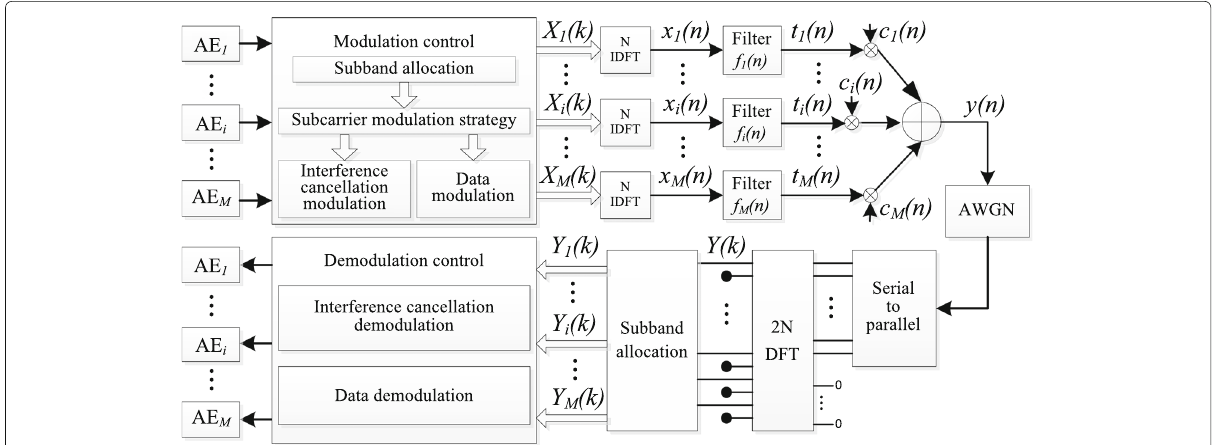
Fig. 1 Block diagram of modified UFMC under consideration of CFO. This figure illustrates the UFMC system model together with the proposed interference cancelation